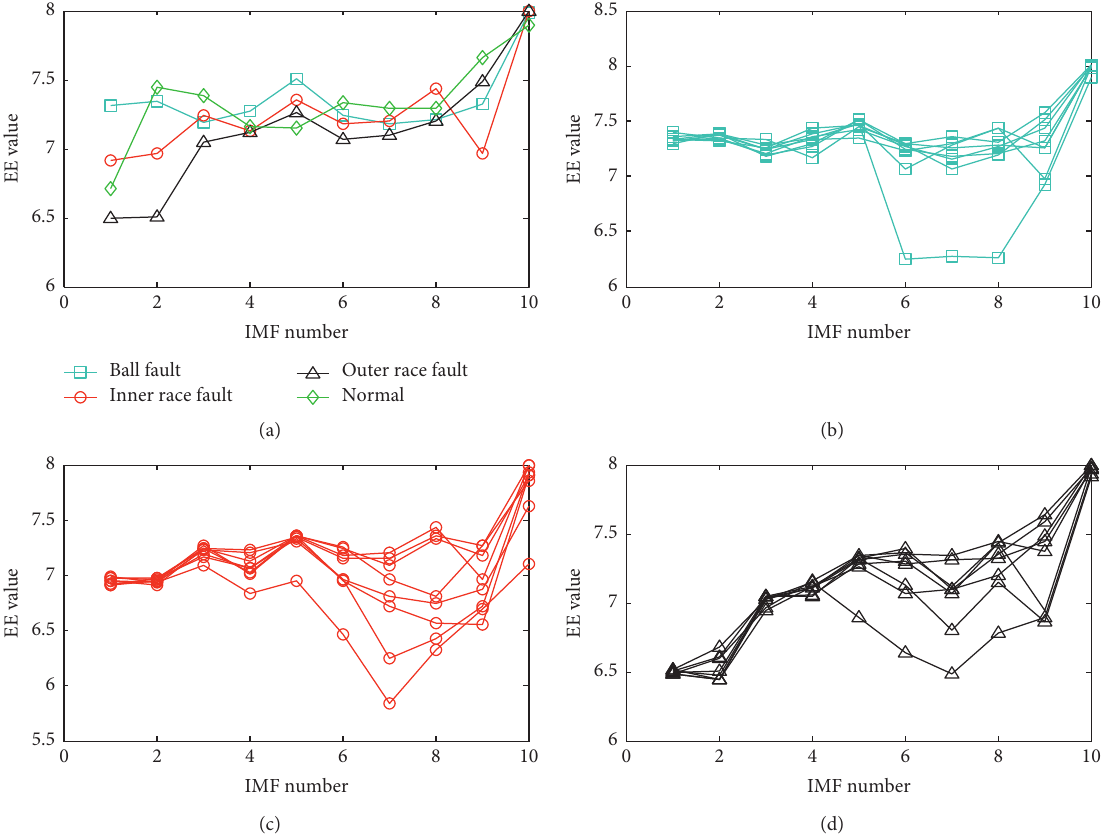
Figure 9: The distribution patterns of EE on different IMF components. (a) The average EE values of each IMF component of different fault conditions. (b) 8 samples of ball fault. (c) 8 samples of inner race fault. (d) 8 samples of outer race